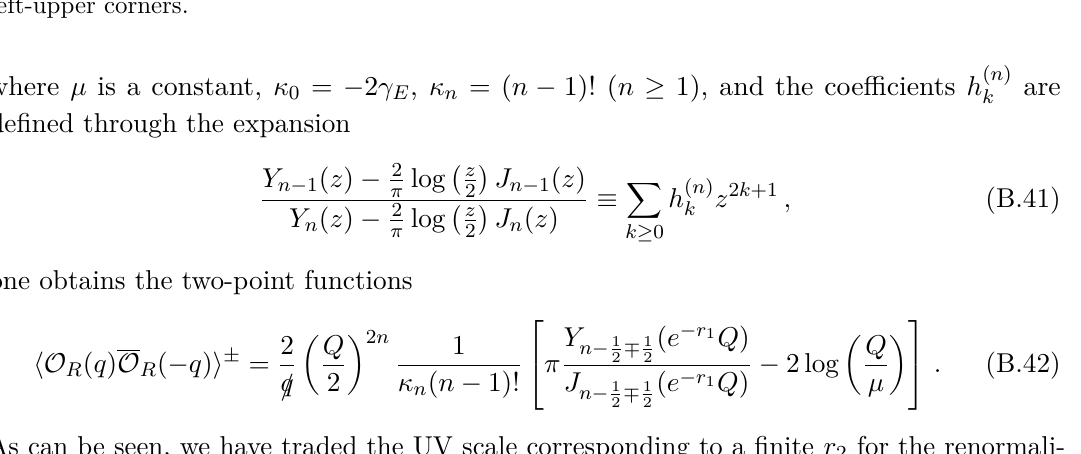
Figure 25 . Bosonic spectrum for Model I (left panel) and Model II (right panel), as a function of x F and ∆ φ , respectively. In Model I, we used ∆ = 2 . 5 , g 5 = 8 , r 1 = 10 − 10 , and r 2 = 15 . In Model II, we used x F = 1 , ∆ = 3 , g 5 = 8 , ∆ φ = 0 . 2 , r 1 = 10 − 12 , and r 2 = 15 . Both plots are normalised in units of the decay constant ˜ f . The colour coding for the spectrum is: singlet scalar (blue), non-singlet scalar (blue diamonds), tensor (red), pseudoscalar (black), vector (green), axial-vector (green diamonds); for further details see [1]. In Model I, since ∆ > 2 , there is also a massless dilaton in the spectrum. In both panels, it is understood that heavier states are present in the right- and left-upper